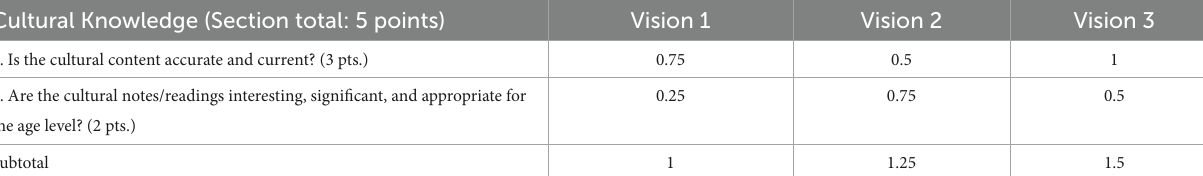
TABLE 6 Evaluation of Vision Series cultural knowledge according to ACTFL. Cultural Knowledge (Section total: 5